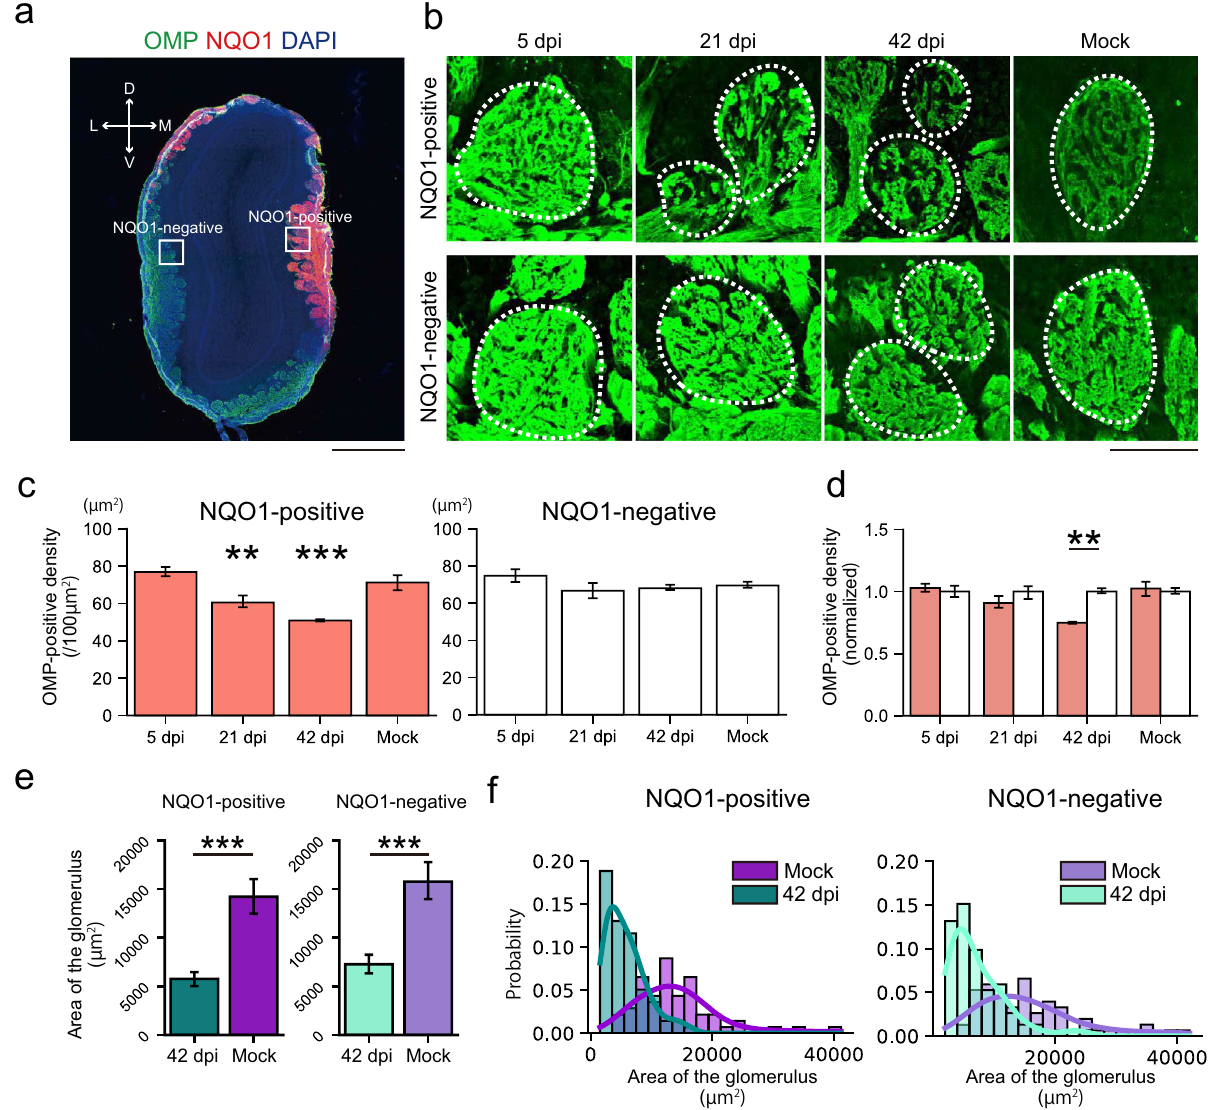
Figure 5. Region-specific changes in the glomeruli in the olfactory bulb (OB) due to SARS-CoV-2 infection. (a) Representative coronal section of the OB stained with olfactory marker protein (OMP), NQO1, and DAPI. Scale bar, 1 mm. (b) Representative time series of glomeruli stained with OMP. Each circled area corresponds to a glomerulus. Scale bar, 100 μm. (c) The density of OMP-positive areas within the glomerulus compared between NQO1-positive or -negative regions. (n = 3, one-way ANOVA followed by Dunnett’s post hoc test. **p < 0.01, ***p < 0.001). (d) Comparison of the normalized OMP-positive area in NQO1-positive and NQO1- negative regions. (n = 3, Welch’s t-test. **p < 0.01). (e) The size of the glomerulus at 42 dpi and mock. (Welch’s t-test. ***p < 0.001). Number of samples; n = 78, 60, 86, and 67 glomeruli from 42 dpi of NQO1-positive, mock of NQO1-positive, 42 dpi of NQO1-negative, and mock of NQO1-negative, n = 3 animals in individual group. (f) Histogram of the area of the glomerulus. The regression curves were fitted using kernel density